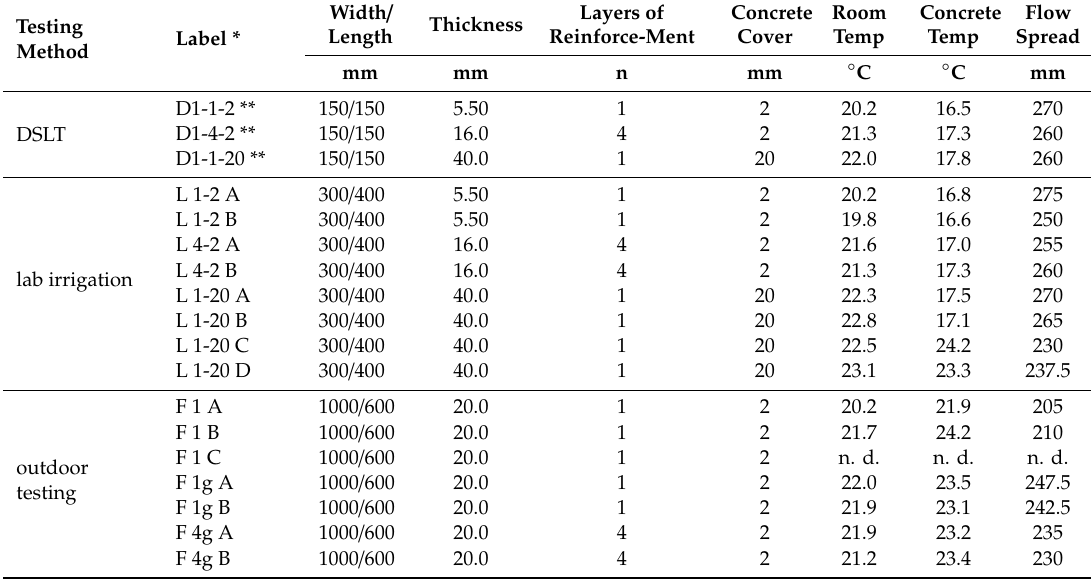
Figure 5. Photo documentation of the test specimens molding process [30]; ( a ) empty formwork and cut textiles; ( b ) first concrete layer; ( c ) textile layer; ( d ) filled formwork; ( e ) sealed (left) and unpacked specimens in formwork. Table 5. Dimensions and production conditions of the investigated test specimens [30].